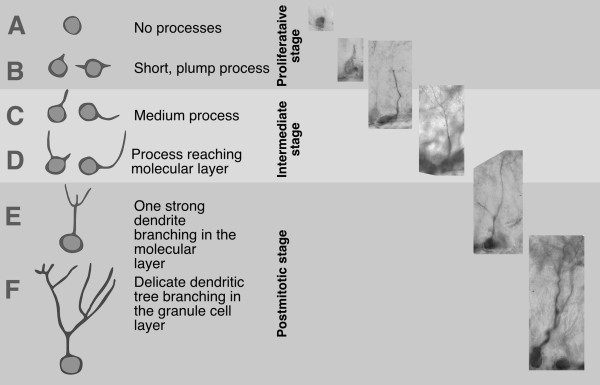
Categorization of dendritic morphology. We devised a schema of six categories of dendritic morphology in order to facilitate the semiquantitative description of the development of DCX-positive cells. The focus is on apical dendrites because basal dendrites were not clearly discernible under physiological conditions. In reality, the six categories, A through F, reflect a continuum. The right half of the figure shows light microscopic images of DCX expressing cells in the SGZ to exemplify the six categories of maturation.